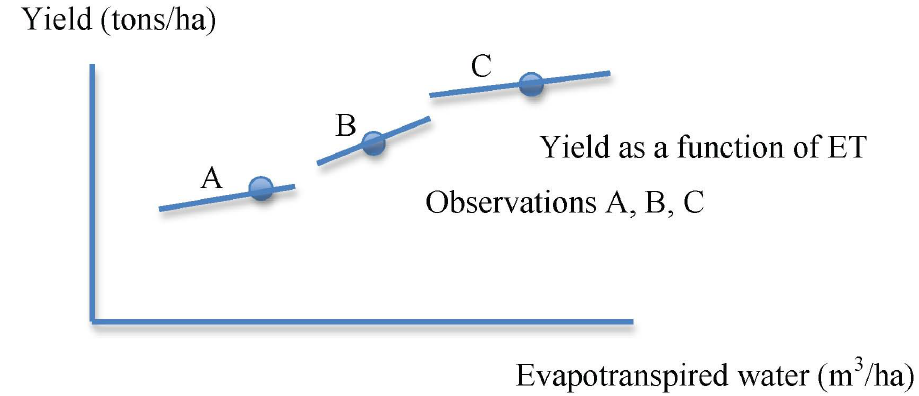
Figure 9. Comparing observations of water productivity, with respect to